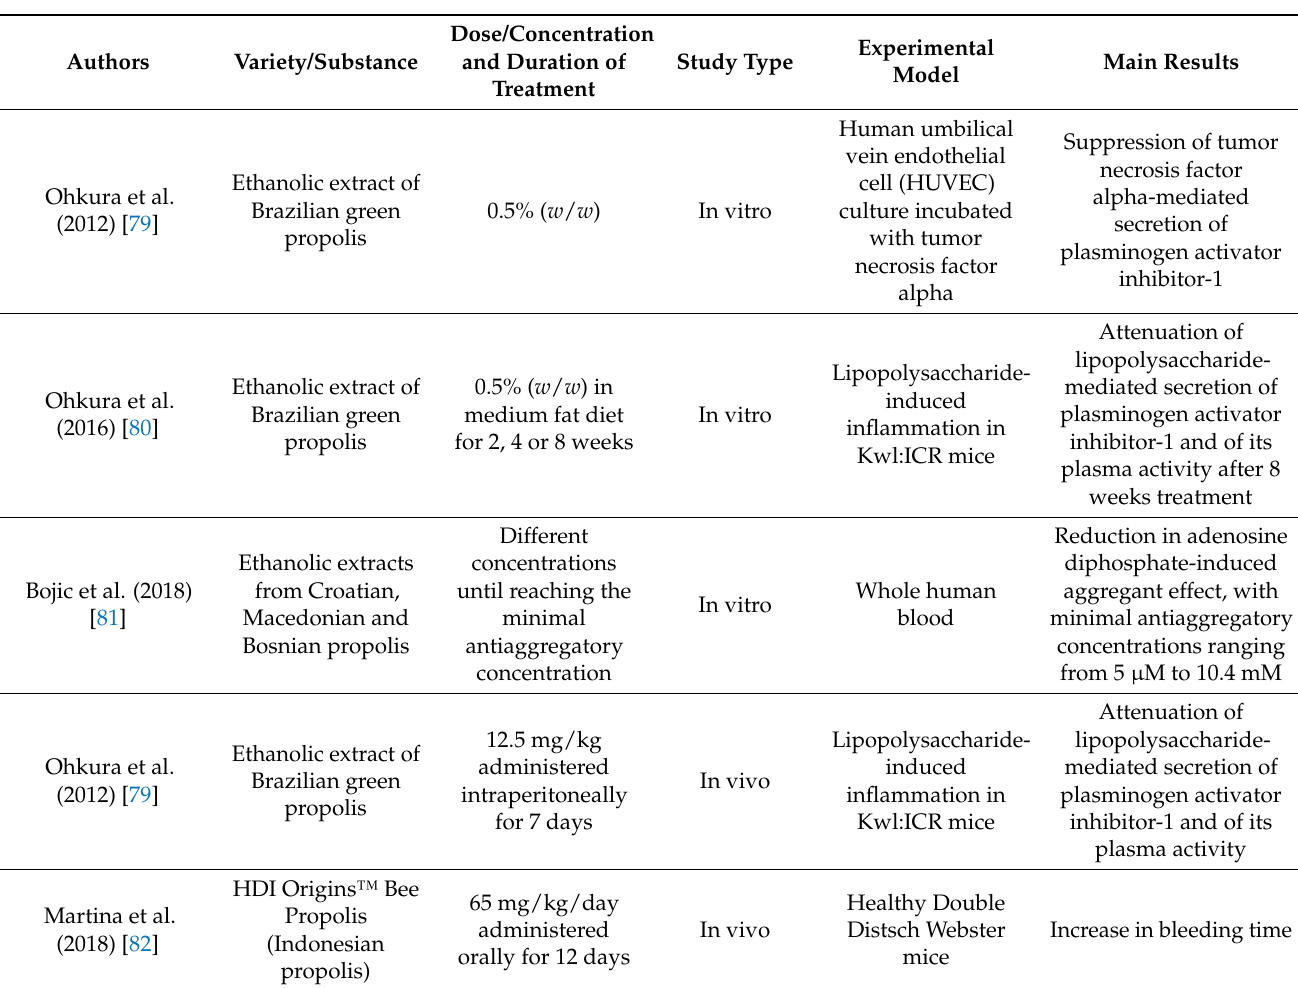
Table 3. Description and main results of the most relevant studies assessing the anti-hemostatic activity of